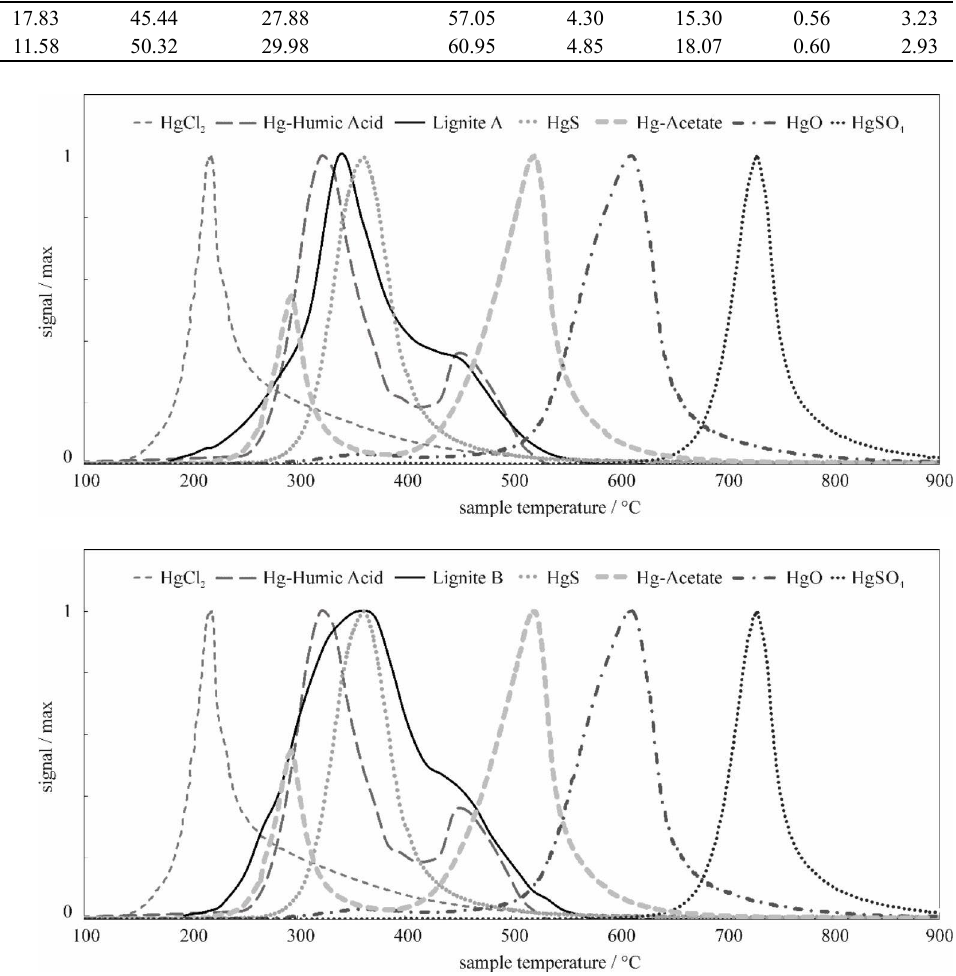
Table 2 Proximate and ultimate analyses of the lignite samples Sample